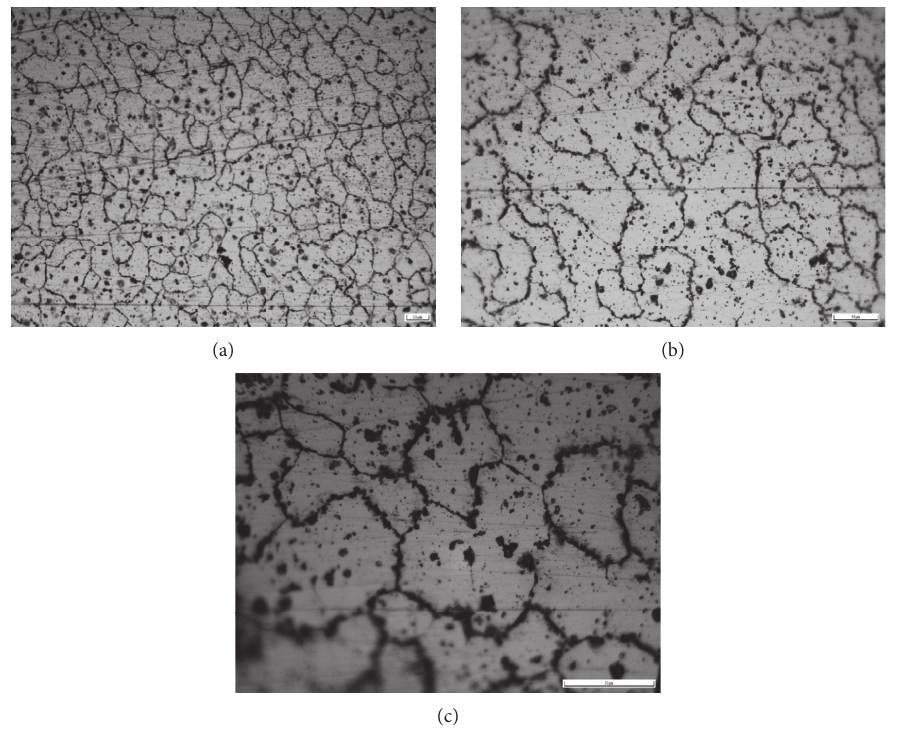
Figure 5: The microstructure of different sample sections at 100 (a), 200 (b), and 400 (c) time